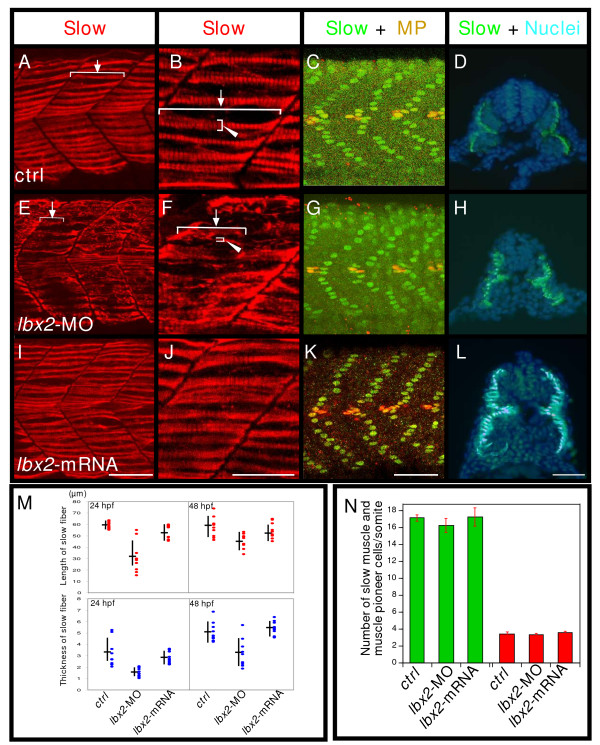
Knockdown of Lbx2 activity results in malformation of slow muscle fibers. A-D: Control embryos. E-H: lbx2-MO injected embryos. I-L: lbx2 mRNA injected embryos. (A-B, E-F, I-J) Embryos labeled with the slow muscle marker, F59 (red). (B, F, J) Higher magnification. Rostral-caudal extension of slow fibers is severely affected by lbx2 knockdown (B, F, arrows). M: Statistical analyses of mean filament rostral-caudal length (arrows) and dorsoventral thickness (B, F, arrowheads). Analysis by ANOVA demonstrates significant differences in length (P < 0.01) and thickness (P < 0.05). (C, G, K, N) Embryos labeled with Prox1 (green, nuclear slow muscle and muscle pioneer marker), and 4D9 (red, Eng, muscle pioneer marker,). Green indicates slow muscle cells and yellow shows muscle pioneers (MP). (ctrl: n = 10, lbx2-MO: n = 6, lbx2-mRNA: n = 4). No apparent differences can be detected between controls and embryos injected with lbx2-MO. N: Analysis by ANOVA demonstrates no significant differences. The data represent the average +/- s.e.m. (D, H, L) Transverse sections of a 24 hpf embryo labeled with the slow muscle marker, F59 (green) and Hoechst to mark nuclei. Slow muscle cells migrate properly to the superficial layer. (A-C, E-G, I-K) Lateral views, rostral toward the left, dorsal toward the top; (D, H, L) dorsal toward the top. Scale bar: (A, C-E, G-I, K-L) 50 μm; (B, F, J) 25 μm.